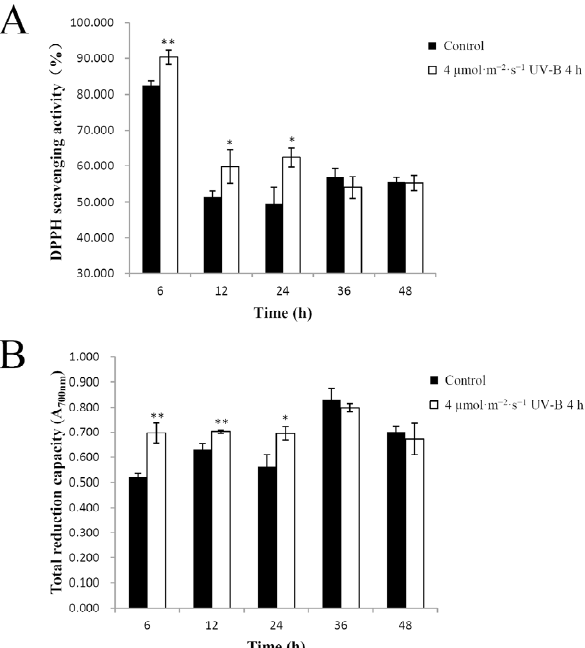
Figure 3. Duration of UV-B radiation effects on the antioxidant capacity of pakchoi. ( A ) The DPPH scavenging activity of 25-day-old seedlings at 6 h, 12 h, 24 h, 36 h, or 48 h after irradiation with 4 µmol·m − 2 ·s − 1 UV-B radiation for 4 h. ( B ) The total reduction capacity of 25-day-old seedlings at 6 h, 12 h, 24 h, 36 h, or 48 h after 4 µmol·m − 2 ·s − 1 UV-B radiation for 4 h. Plants grown without UV-B ra- diation served as controls. Three independent biological replicate experiments were performed; data points represent the mean ± SE of the three biological replicates. Asterisks indicate a signifi- cant difference (* p < 0.05; ** p < 0.01) relative to the corresponding control, using Student’s t -test.